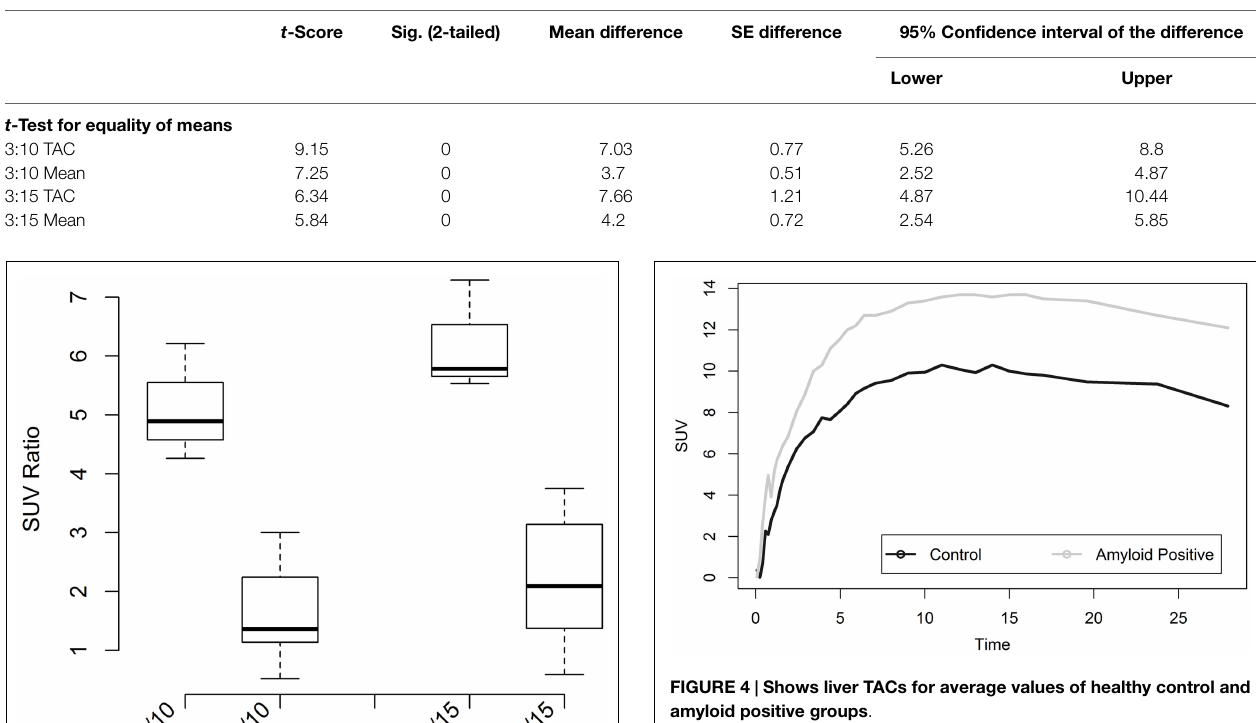
TABLE 4 | t -Test results for SUV ratios